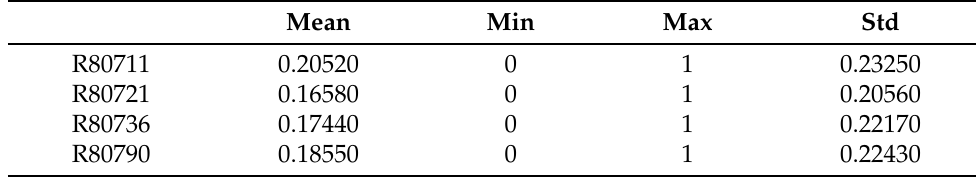
Table 2. Target data details and statistics.